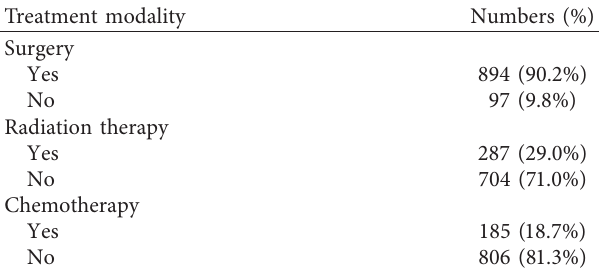
Table 1: Patient and tumor characteristics. Table 2: Summary of treatment: treatment modality.